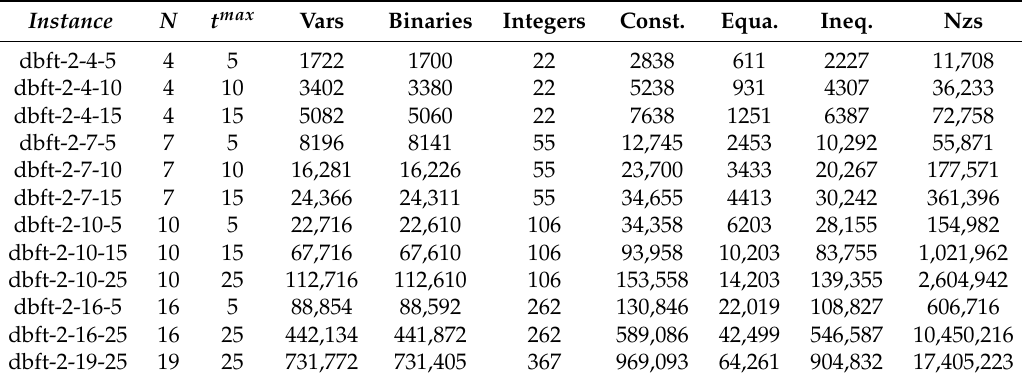
Table 1. Generated instances with distinct sizes N and t max